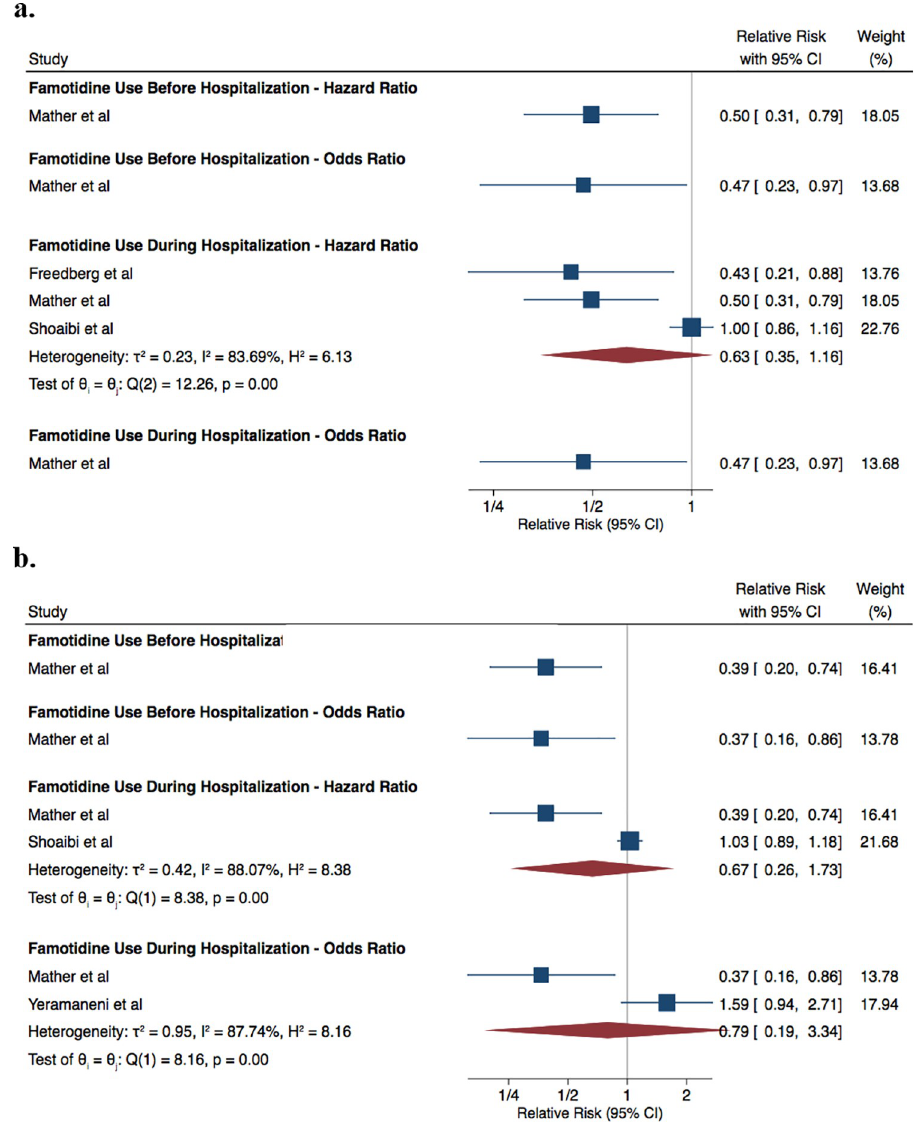
Fig 2. Meta-analysis of relative risk, compared to standard of care a. composite outcomes b.